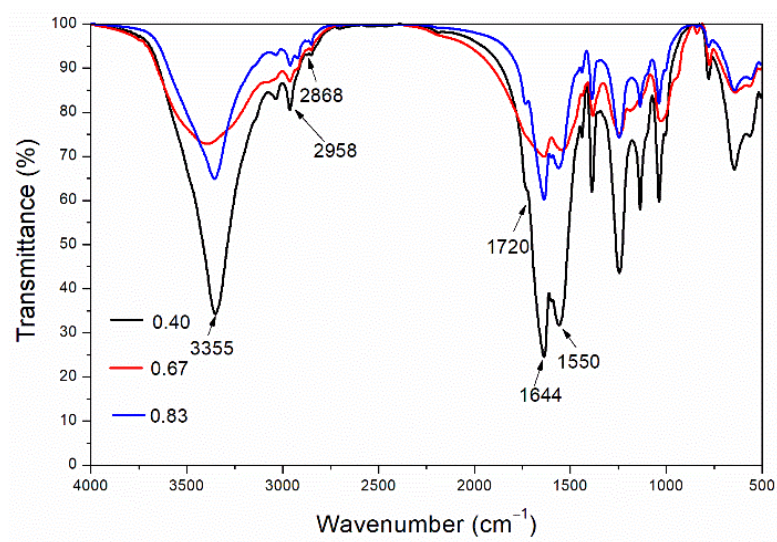
Figure 2. Infrared spectrum of the microcapsules with different core-wall ratios